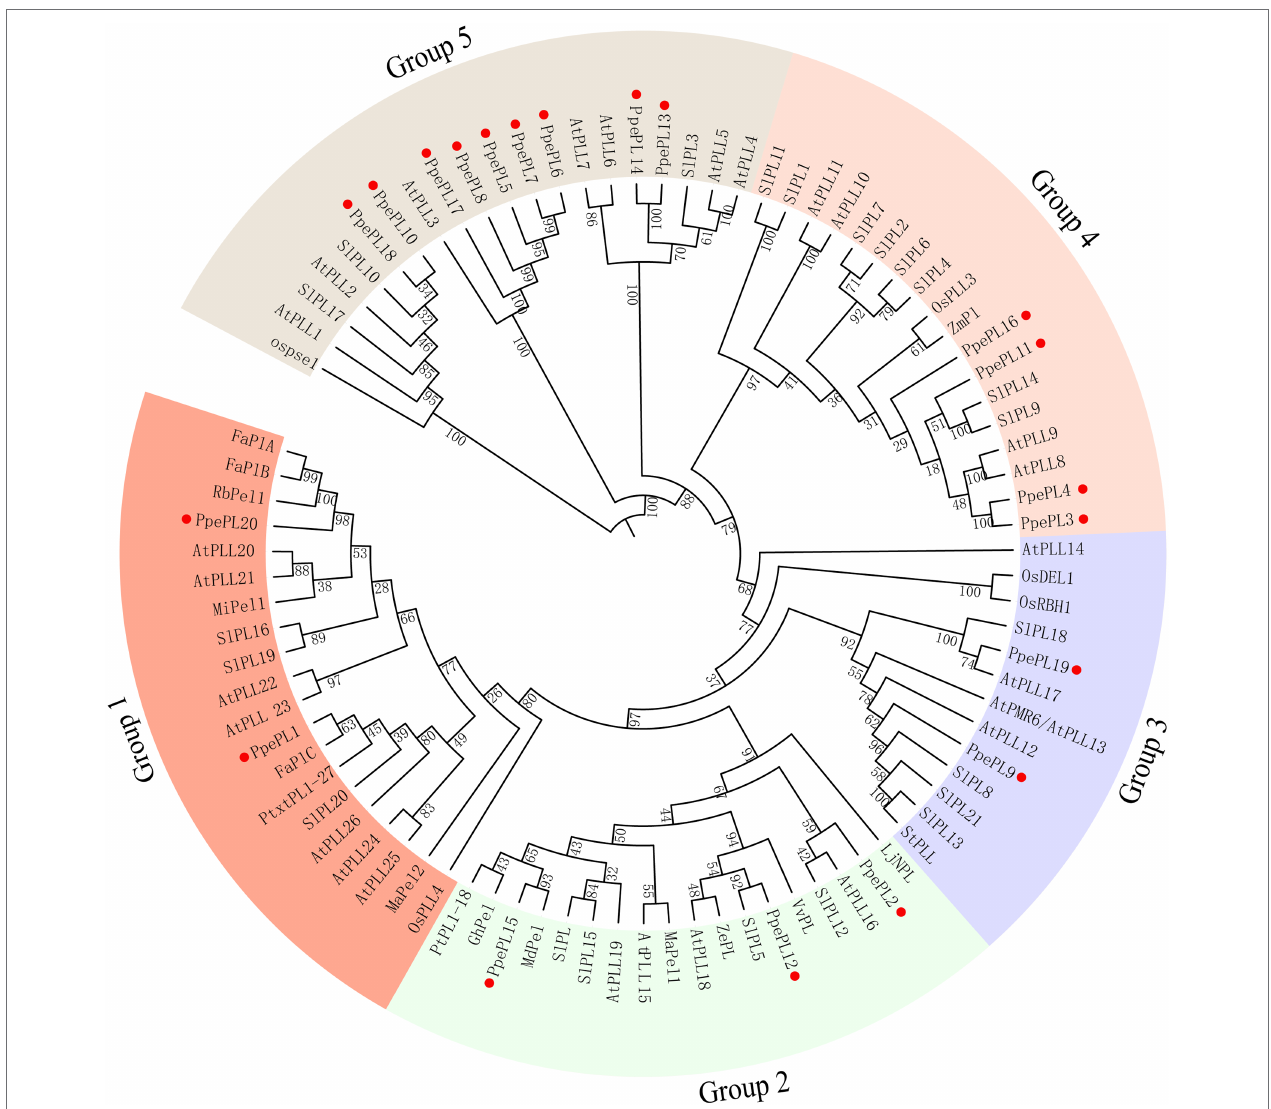
FIGURE 3 | Phylogenetic tree of PLs from peach and other species. The PL proteins are clustered into five groups, marked by different colors. The red circle represents the PpePL members. Species shown are Arabidopsis thaliana (At), Prunus persica (Ppe), Fragaria × ananassa (Fa), Musa acuminate (Ma), Malus domestica (Md), Vitis vinifera (Vv), Mangifera indica (Mi), Zinnia elegans (Ze), Zea mays (Zm), Solanum tuberosum (St), Rosa bourboniana (Rb), Lotus japonicus (Lj), and Solanum lycopersicun (Sl). All protein sequences with gene IDs in the phylogenetic tree are listed in Supplementary Table S3